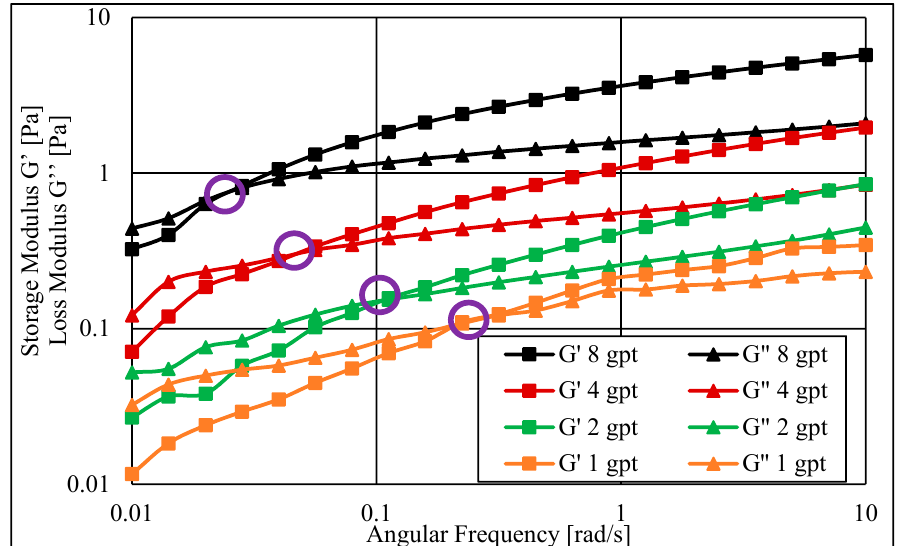
Figure 7. Elastic properties of the HVFR at different concentrations at 25 °C.